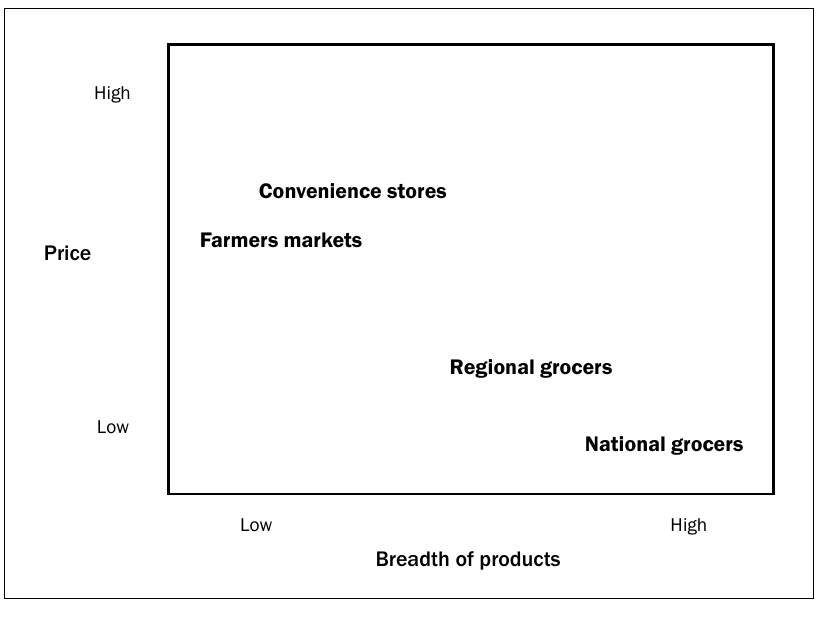
Figure 3. Strategic Group Map: Food Retail and Relative Size The size of font is for illustrative purposes only; it is not based on real market